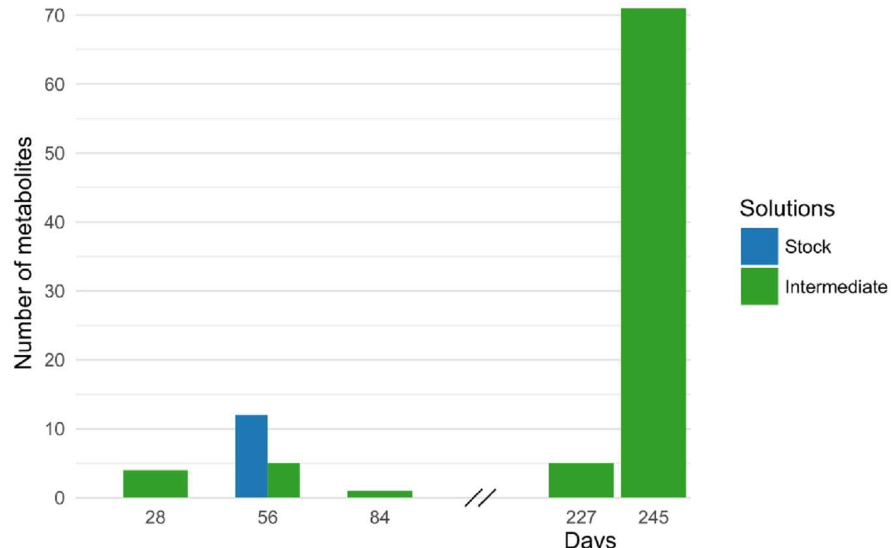
Figure 5. Bar graph representing the stability of stock solutions and intermediate solutions of metabolites that were used to prepare calibration curve standards during the analysis. First, the stability was determined at the intermediate concentration levels (green bar) and then at the stock level (blue bar) only for those metabolites, which were not stable at the intermediate concentration level.